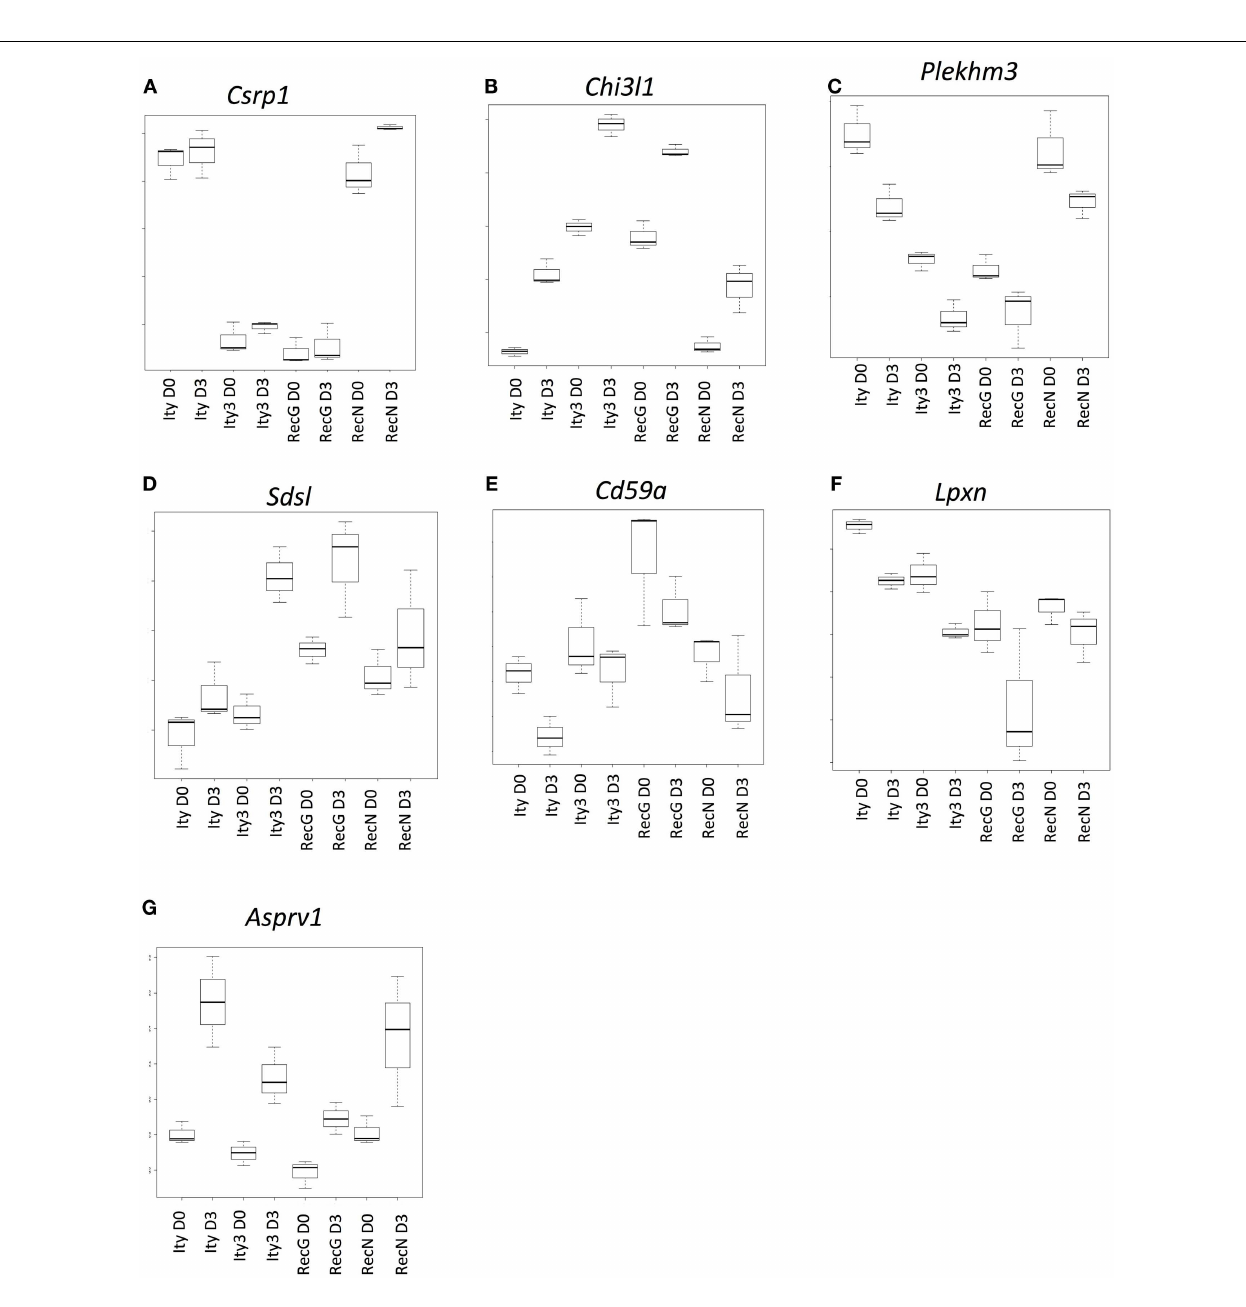
FIGURE 3 | Genes that are under the control of the Ity3.1 locus . Sample box plots of the gene lists provided inTable S2 in Supplementary Material are shown. (A) Represents genes, which do not show any changes in expression during infection and show a similar expression pattern in Ity3 and Ity3.RecG . (B,C) Represents a sample box plot of gene expression, which show a similar regulation pattern in Ity3 and Ity3.RecG . (D–G) Also illustrate genes withinTablesS2D,G in